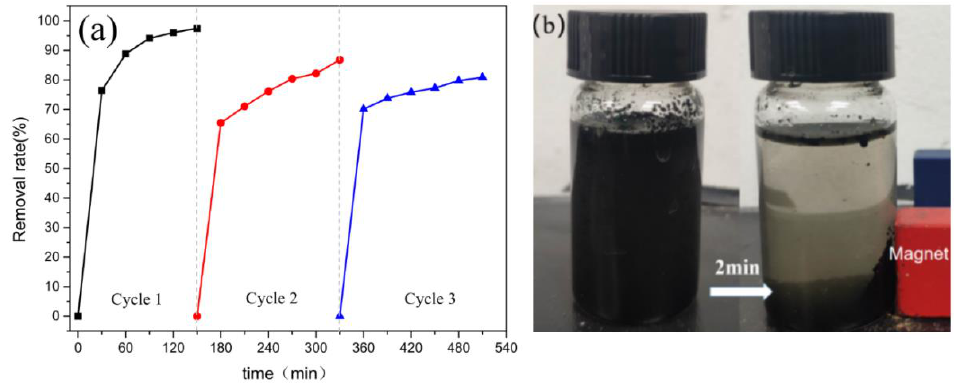
Figure 7. Reusability test for adsorption of MO by CoO@C-500 ( a ); Schematic of the magnetic separation ( b